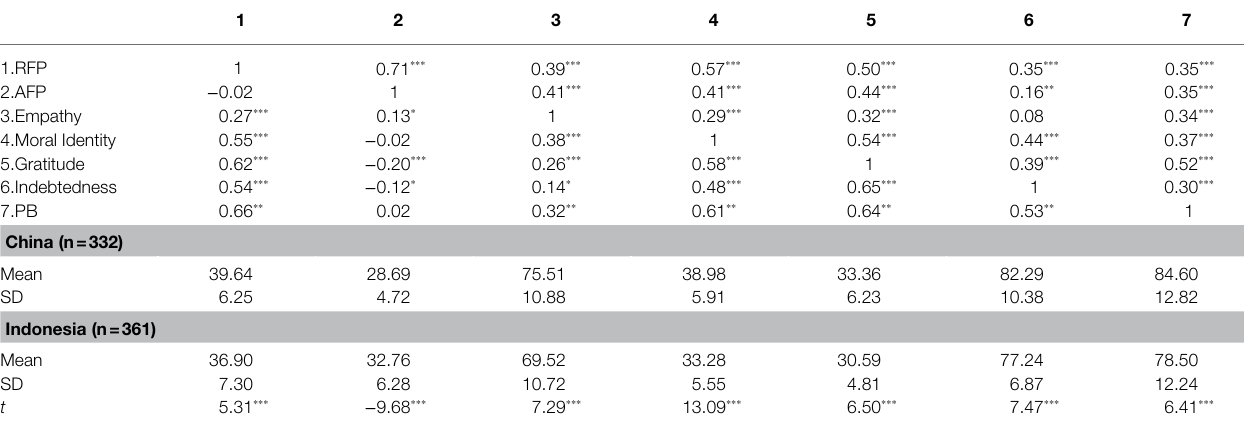
TABLE 1 | Means, SDs, and correlations in different nations ( n =